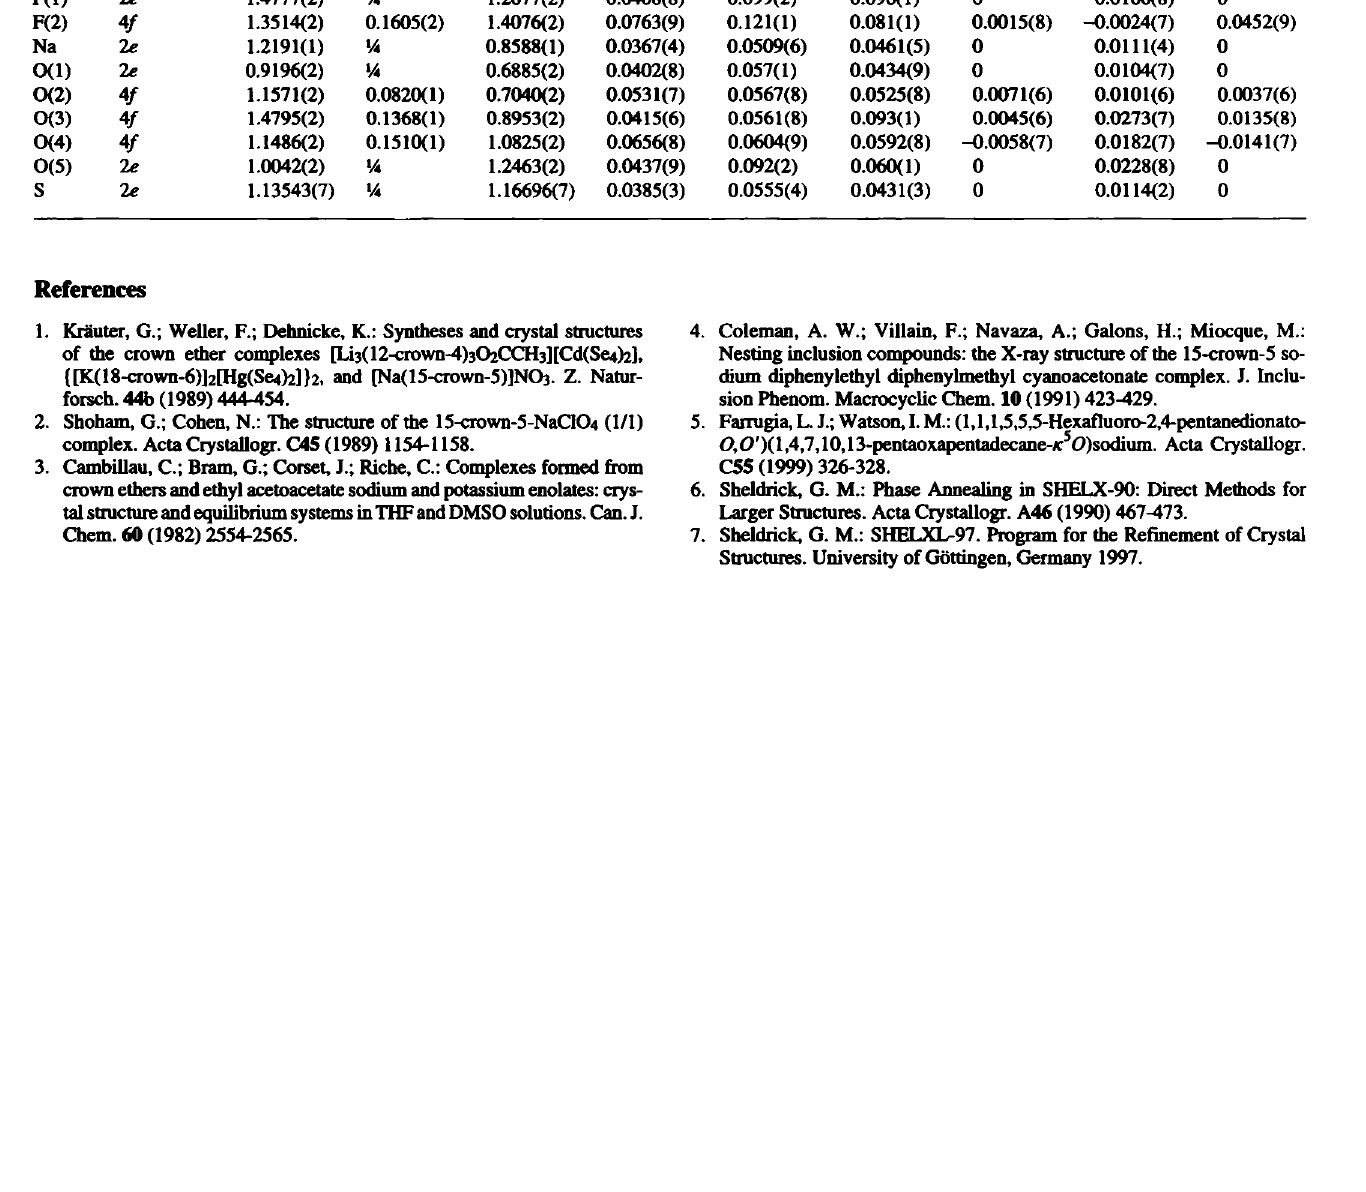
Table 3. Atomic coordinates and displacement parameters (in A 2